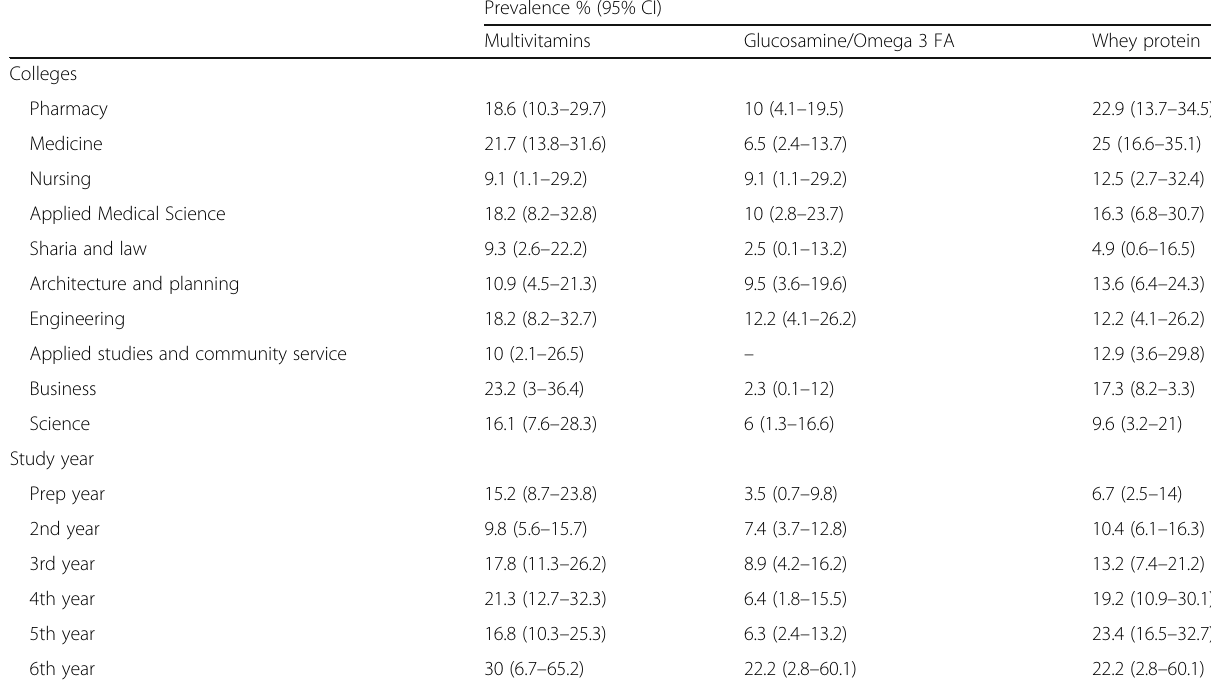
Table 3 College and study year-wise prevalence of multivitamins, glucosamine/Omega 3 FA and whey